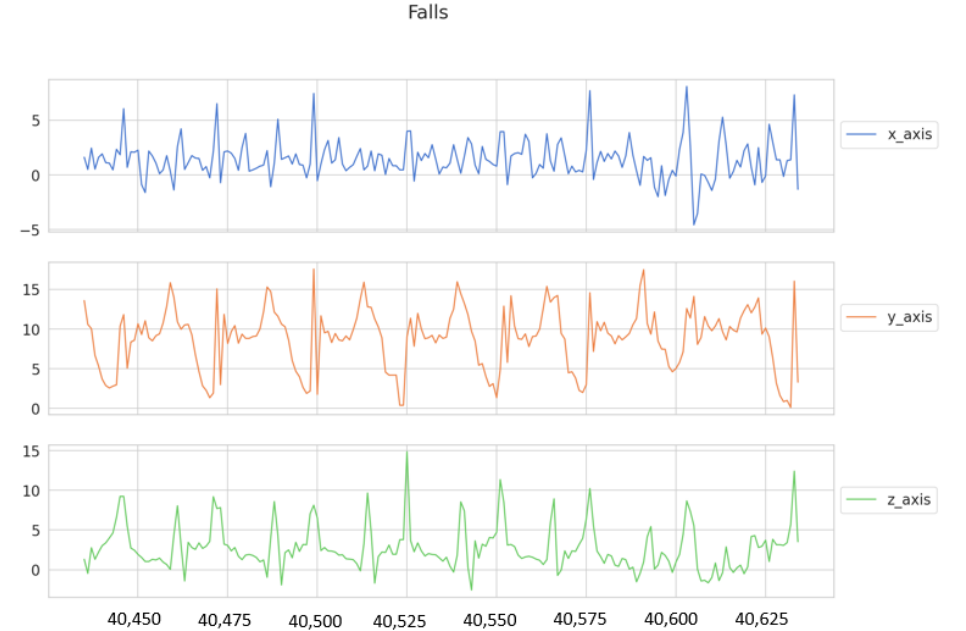
Figure 12. Behavior of the time series for the fall